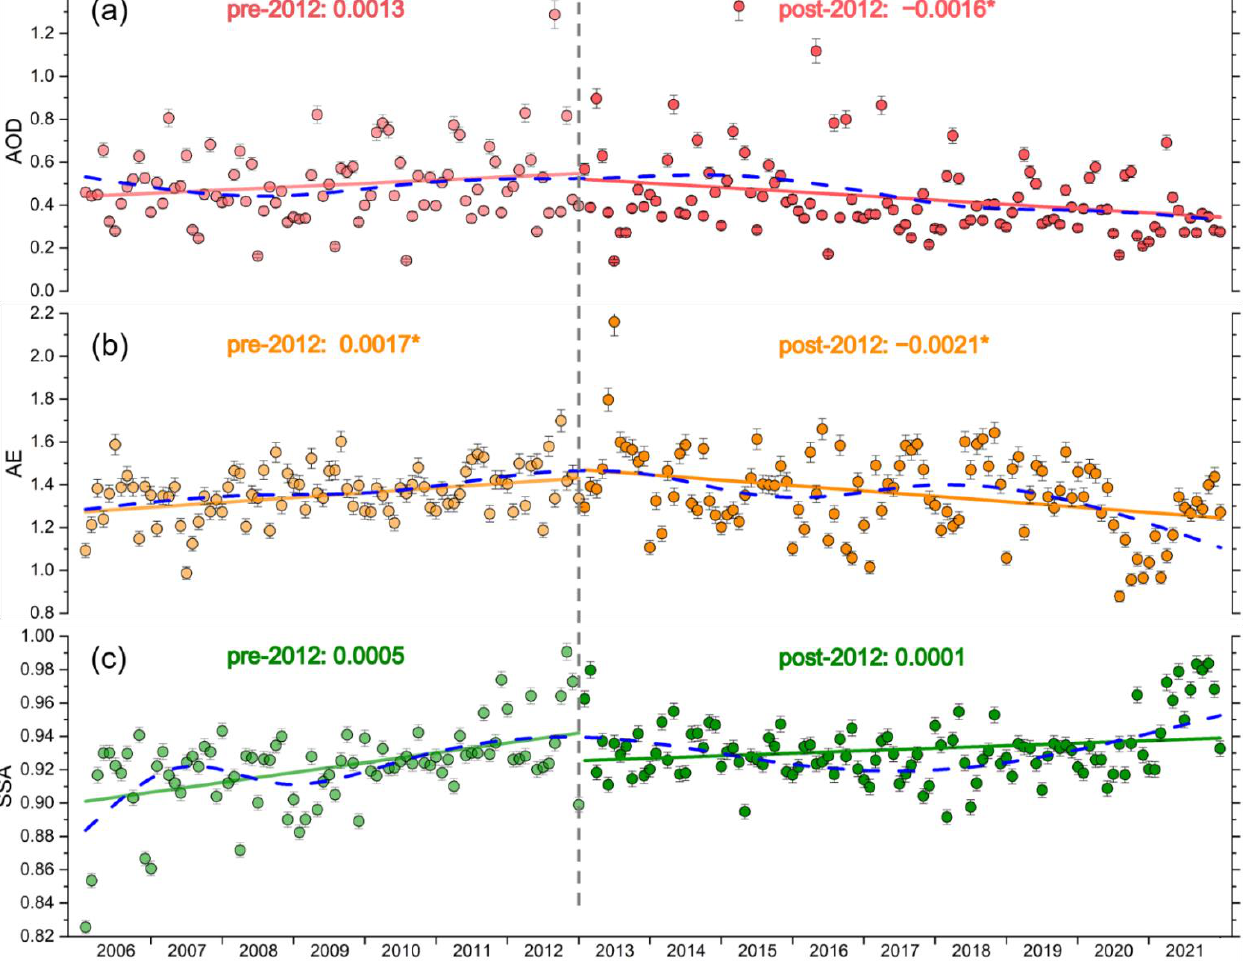
Figure 5. Linear (colored solid lines) and ESMD-based non-linear (blue dashed lines) annual varying trends of ( a ) AOD, ( b ) AE, and ( c ) SSA from 2006 to 2021 based on monthly averaged measurements. (* denotes the linear trends passing the 95% confidence level.)